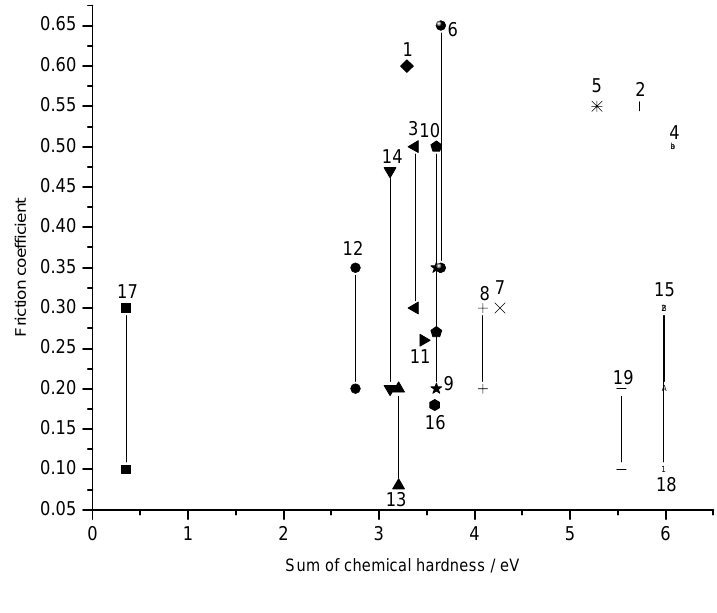
Figure 10. Relationship between friction coefficients and sum of chemical hardness of certain solid oxide pairs with coordination number of 6. (Numbers next to data points correspond to the numbers used in Table 3 for each oxide pair; data of friction coefficient of solid oxides are from